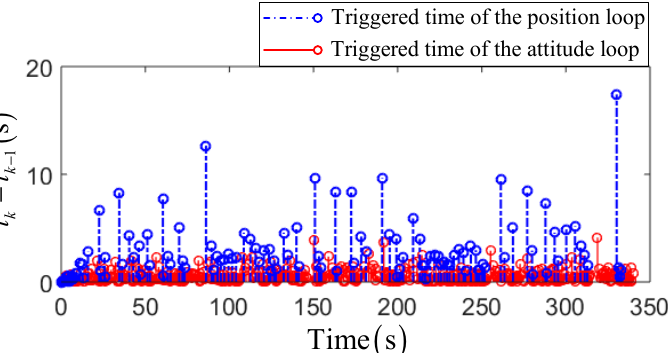
Figure 9. The adaptive parameters for the USV-UAV (( a ) is adaptive parameters for USV. ( b ) is adaptive parameters for UAV).